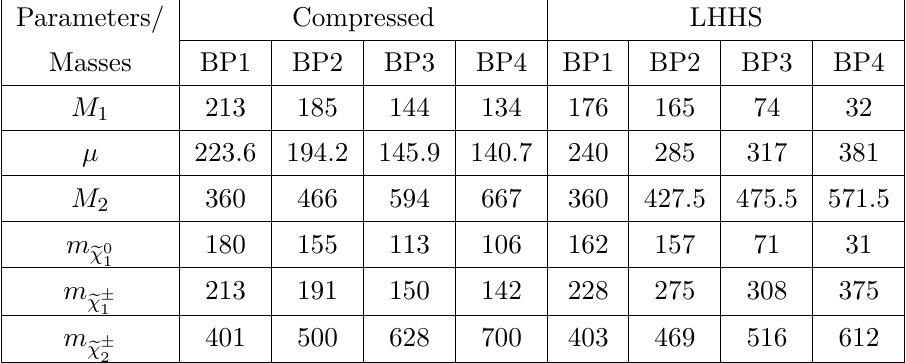
Table 4 . BPs consistent with the LHC and a (cid:22) constraints as derived in section 5. All masses and mass parameters are in